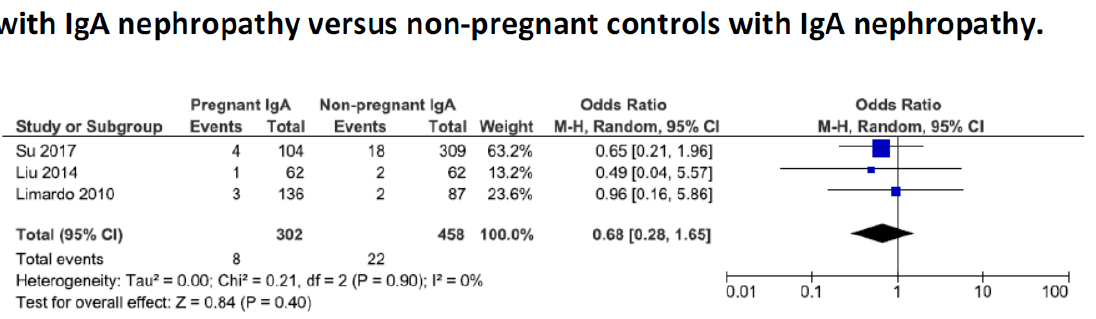
Figure 2. Odds ratio for end-stage renal disease in patients with IgA nephropathy, with or without pregnancy. Legend: ESRD: end stage renal disease. CI: confidence intervals.